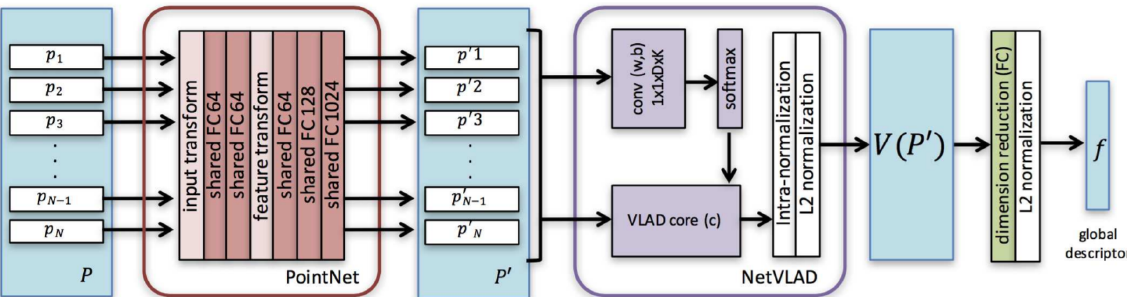
Figure 27. The architecture of our PointNetVLAD [80] network.